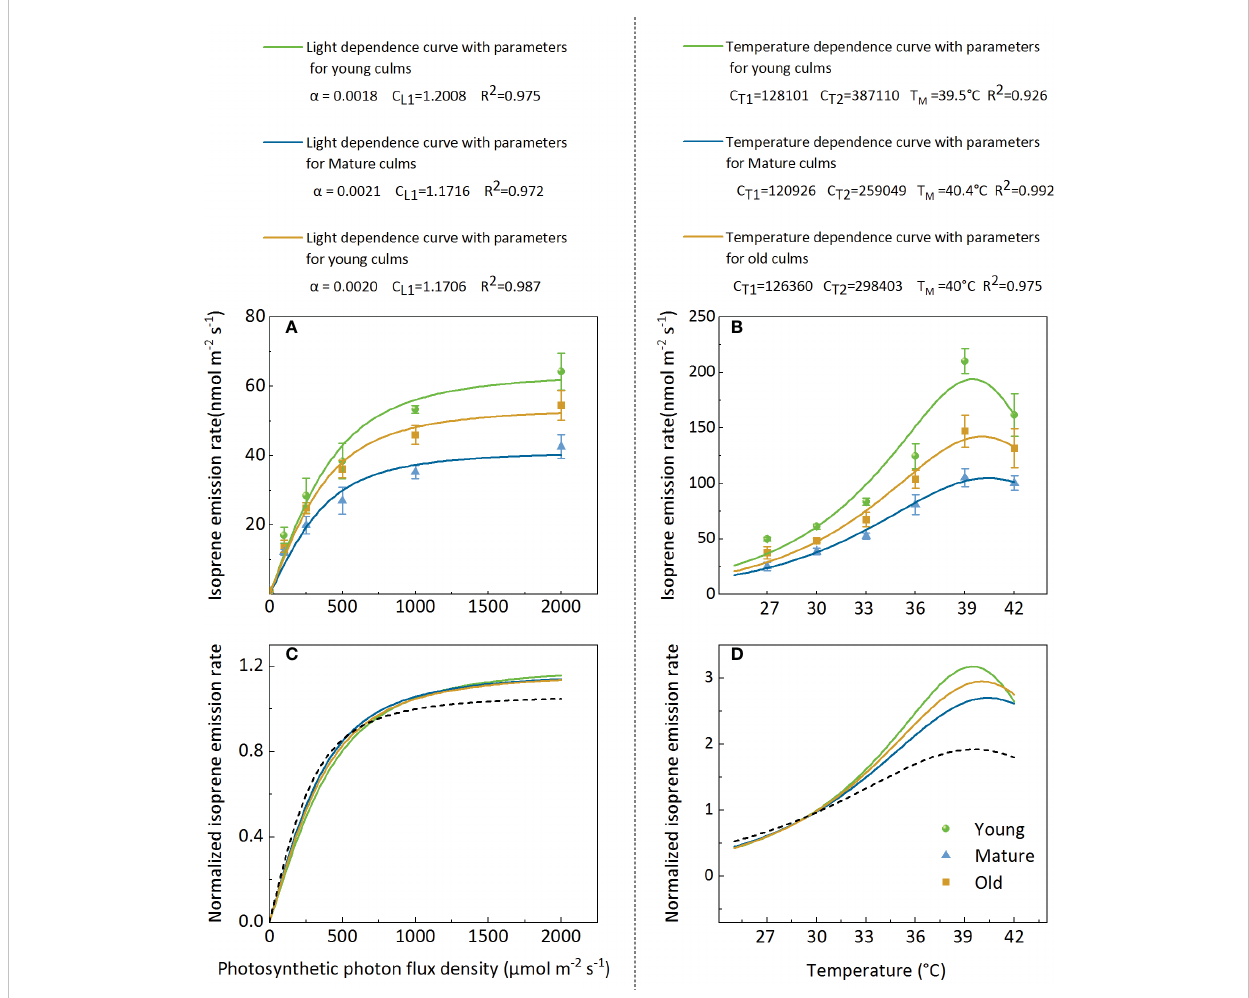
FIGURE 6 Representative light (A, C) and temperature (B, D) dependencies of isoprene emission rate (A, B) and normalized isoprene emission rate (C, D) for leaves in young, mature, and old bamboos. Data in (A, C) were fi tted using Eq.3 with the parameters de fi ned as follows: Es-the isoprene emission capacity, a -the initial quantum yield of isoprene emission, and C L1 -a scaling constant. Data in (B, D) were fi tted by Eq.4, C T1 and C T2 are parameters which can be interpreted as activation and deactivation energy of isoprene emissions (in J mol -1 ), respectively; T M presents the optimum temperature for isoprene